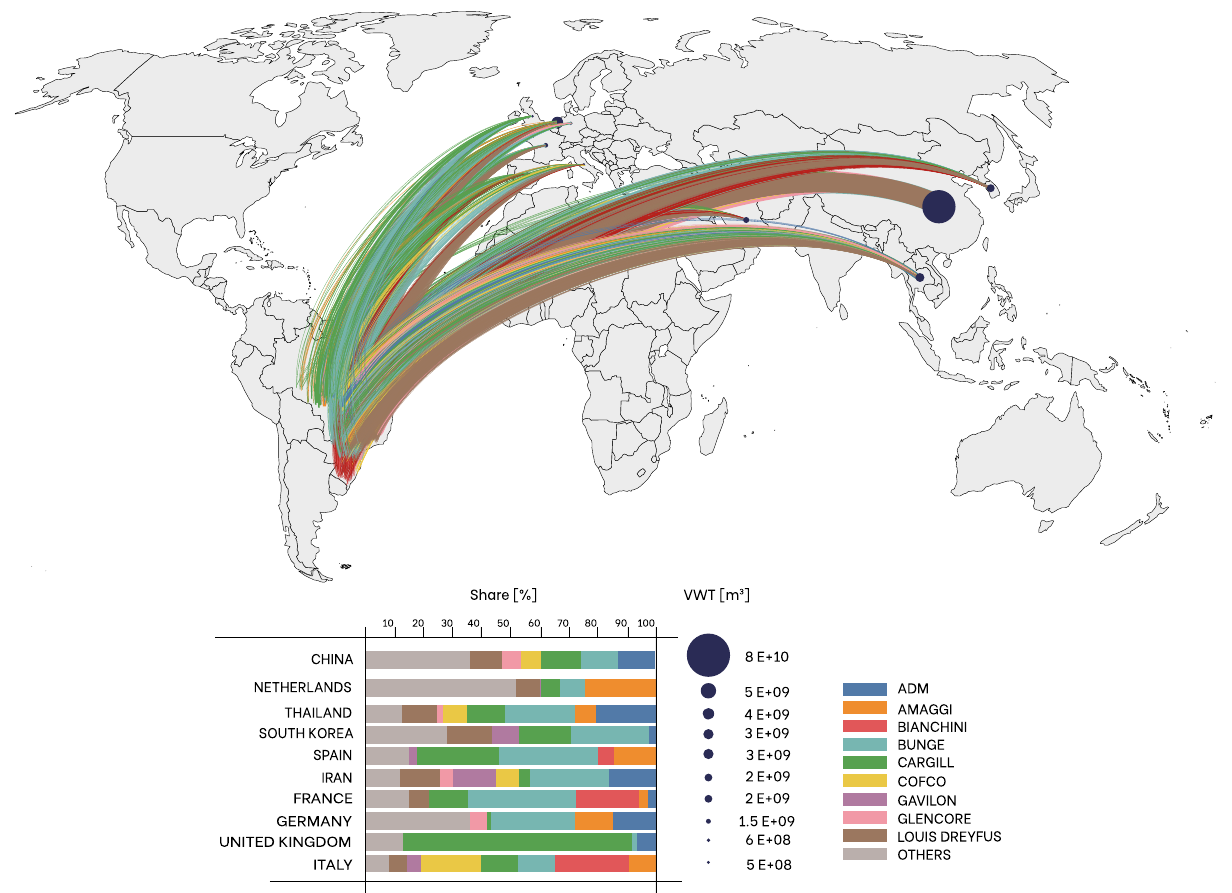
Fig. 1 Spatially explicit virtual water fl ows linking local production sites with traders and importers. Sub-national and company-speci fi c virtual water fl ows (m 3 ) of soybean products from Brazilian municipalities to top importer countries in 2018. The bubble size on the map represents for each country the total traced incoming virtual water volume from all the exporting companies. The colours and the size of the edges identify the trading company and the weight of each virtual water fl ow leaving the Brazilian municipality. Only the edges associated with the top-nine trading companies are shown. The bottom legend shows also the companies' share of the total virtual water import by each country in